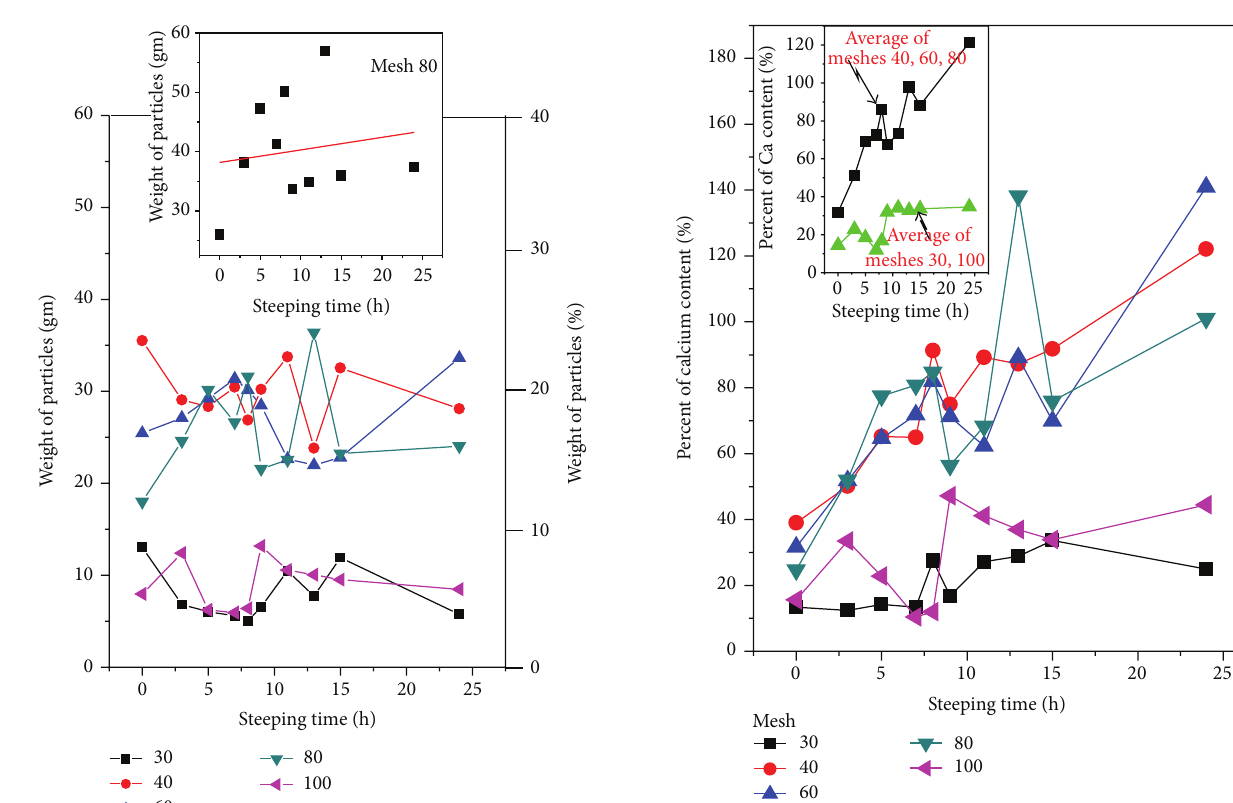
Figure 2: W-PSD versus ST for the five meshes chosen. The inset displays the linear fitting as a first approximation of W-PSD against ST, for the mesh 80, to measure a mean slope of experimental points.